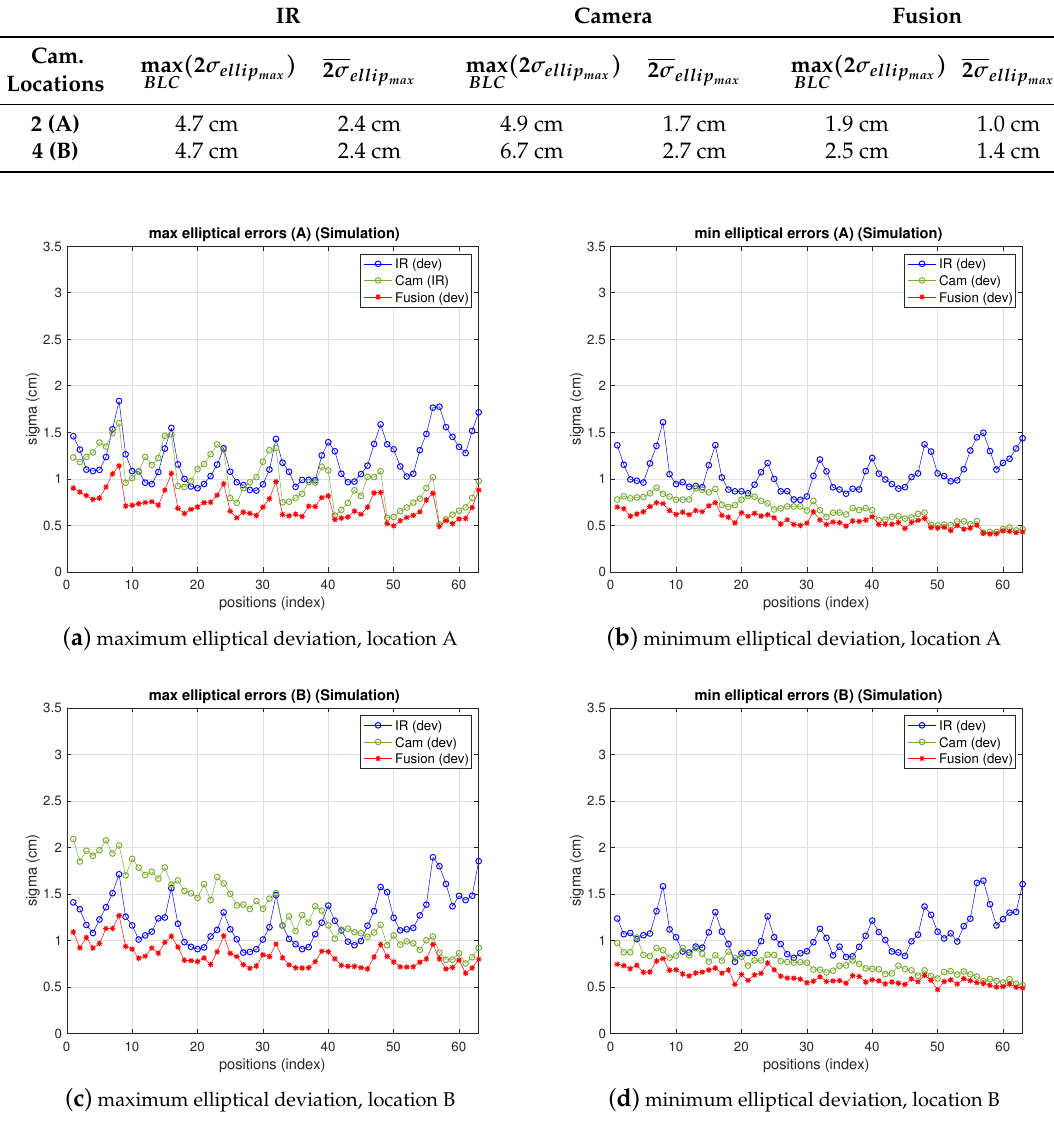
Figure 14. Simulation errors for IR, camera and fusion estimations, emulating locations A (top) and B (bottom). Left: maximum elliptical deviation; right: minimum elliptical deviation. Table 7. Summary of precision for IR, camera and fusion (simulation). IR Camera Fusion